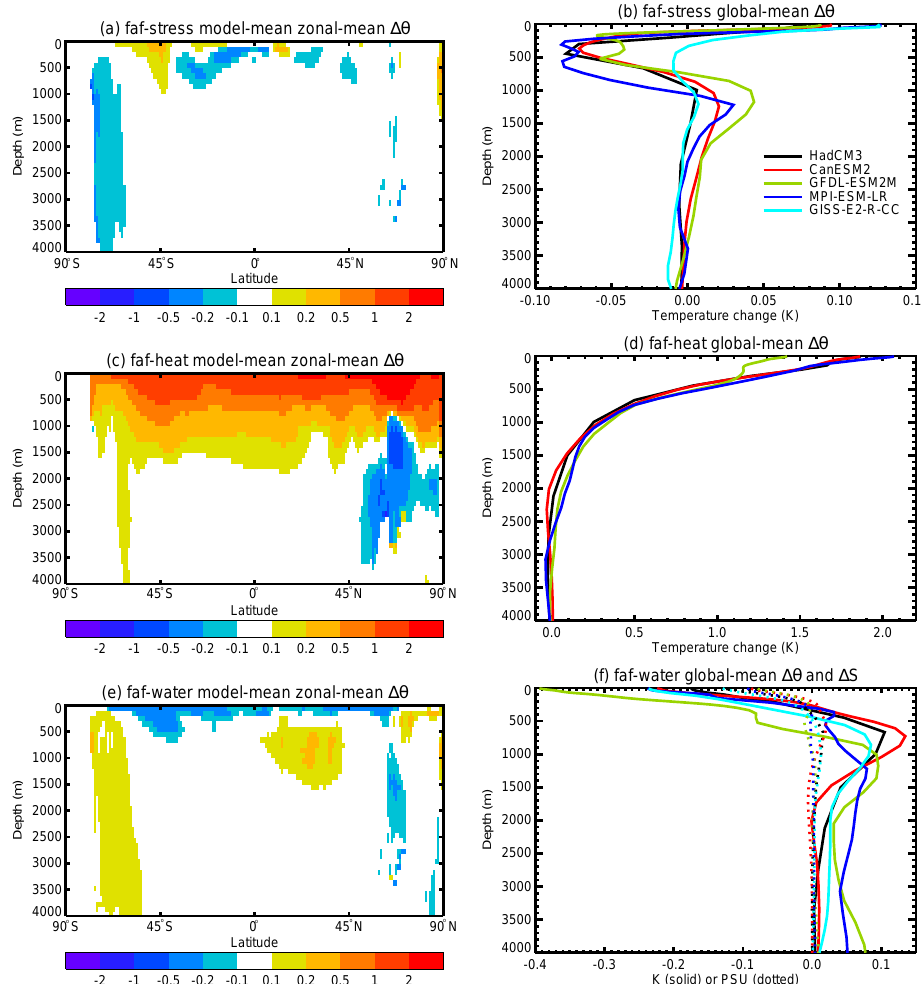
Figure 7. Model-mean change in ocean temperature θ (K) and ocean salinity S (PSU, in f only) in the time mean of the final decade of the FAFMIP experiments relative to the control, model-mean zonal-mean cross-sections on the left, global means as a function of depth of individual models on the right. Note that the panels on the right have different scales for the temperature